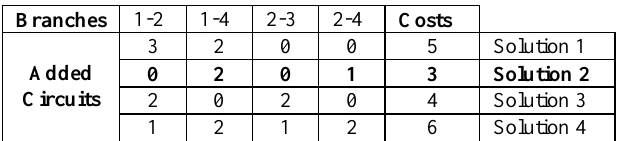
Figure 1: Representation of candidate solutions.